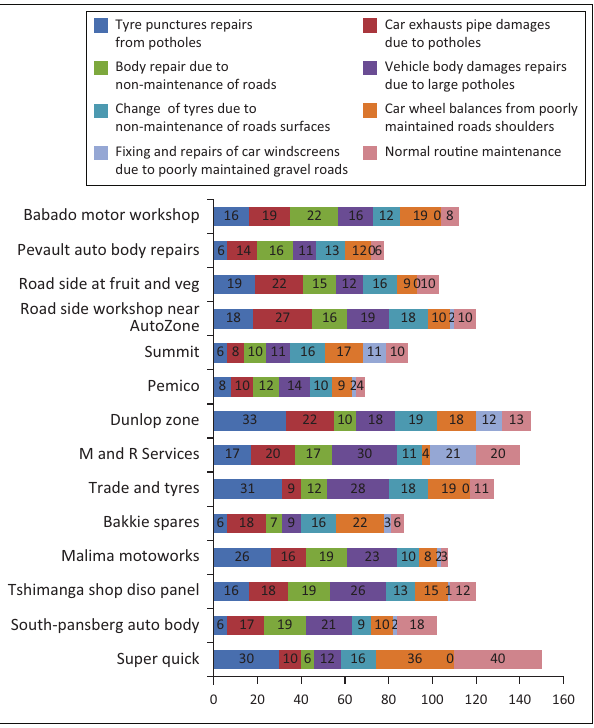
FIGURE 3: Repairs of road junctions in Louis Trichardt, 2015.